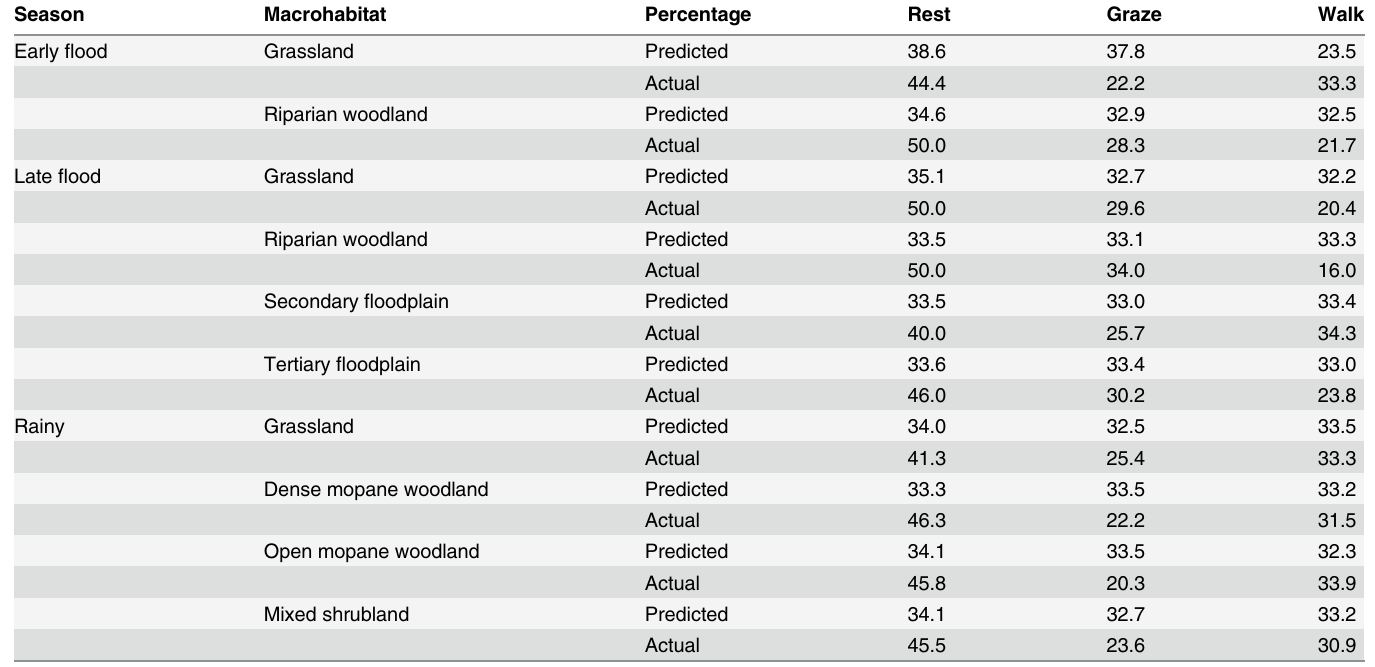
Table 8. Percentages of samples assigned to behaviours from actual data and from multilevel model